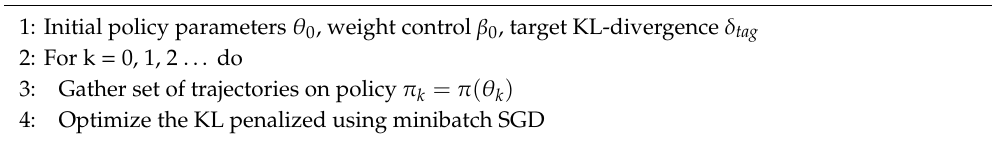
Algorithm 1 PPO with an Adaptive KL Penalty Algorithm